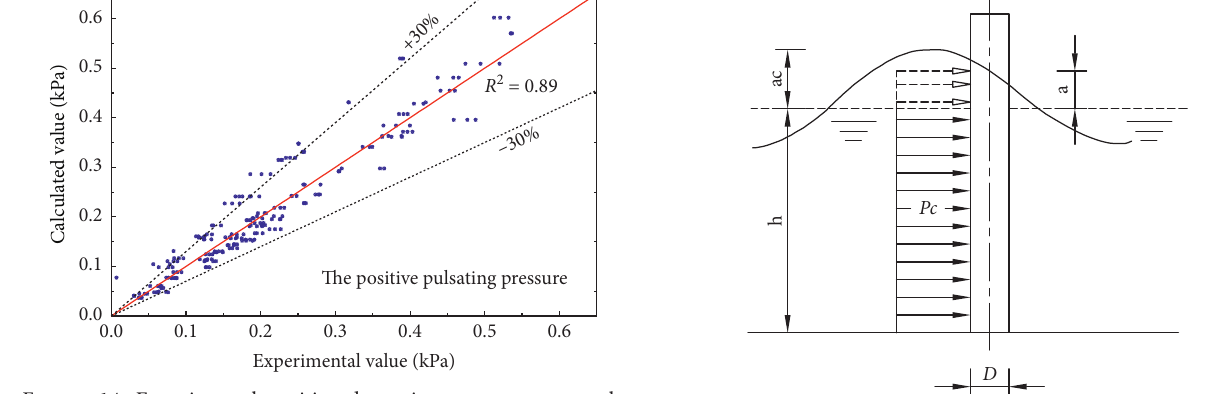
Figure 14: Experimental positive dynamic pressure versus cal- culated results.